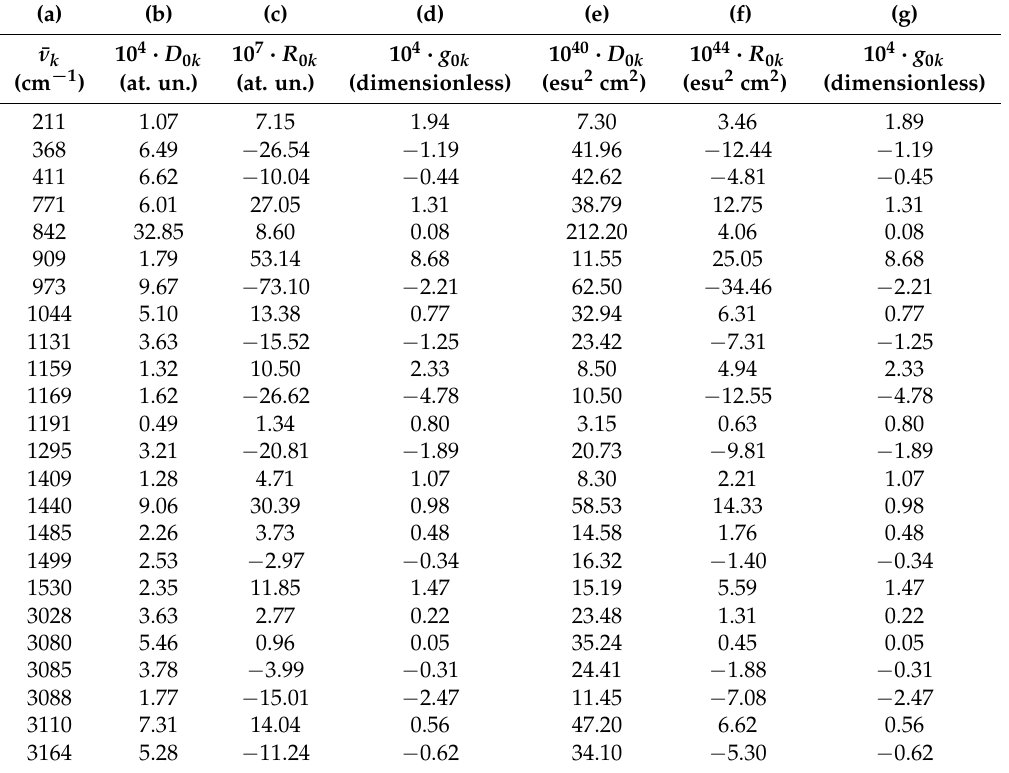
Table 2. Comparison of the results from a VCD calculation carried out with Gaussian09 on ( R )-methyloxirane at the B3LYP/aug-cc-pVQZ level, and the results obtained by a corresponding polar calculation based on the numerical data contained in the *.fchk file associated with the Gaussian calculation. Column (a) is the wavenumbers computed by Gaussian09 and polar are not distinguishable at the shown precision. The APTs and AATs stored in the *.fchk file are used by polar to compute the dipole and rotatory strengths (Columns (b) and (c)) in atomic units (see Equation (14) and Section 4 for details), from which we computed the dissymmetry ratios g 0 k = 4 R 0 k / ( cD 0 k ) listed in Column (d)—please note the use of SI for the electromagnetic field, which implies the factor c = 137.035999074 in atomic units [41]. The dipole and rotatory strengths computed by Gaussian09 (Columns (e) and (f)) are used to compute the dissymmetry ratios g 0 k = 4 R 0 k / D 0 k (cgs system) reported in Column